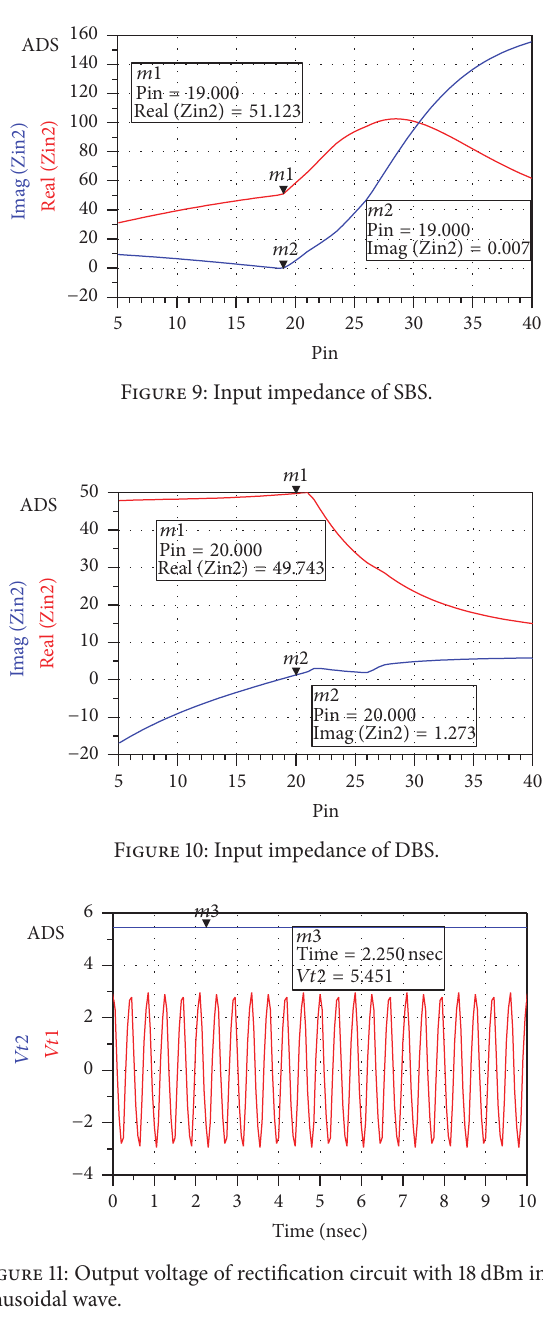
Figure 14: Prototype of the SBS rectification